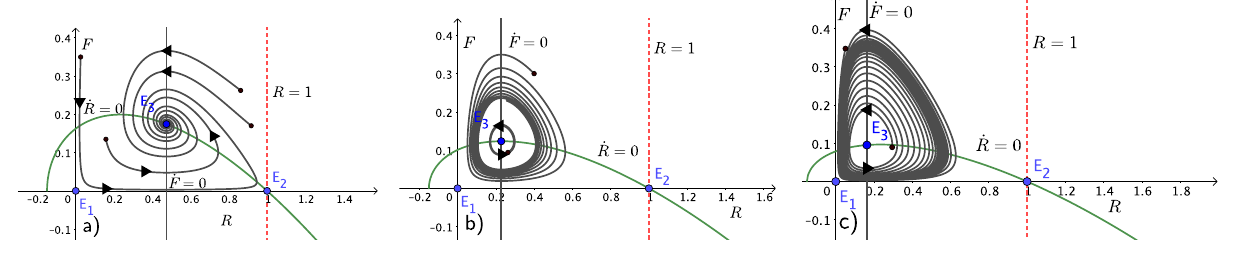
Fig. 4 Taking µ as a variation parameter a limit cycle arises from equilibrium E 3 R , indicating the onset of a Hopf bifurcation. a) For µ = 0 . 65 > µ ∗ , λ = 0 . 7 and h = 0 . 15, E 3 is a stable focus. b) For µ = µ ∗ ≈ 0 . 376, λ = 0 . 7 and h = 0 . 15, E 3 is a weak stable focus. c) For µ < µ ∗ , λ = 0 . 7 and h = 0 . 15 E 3 is an unstable